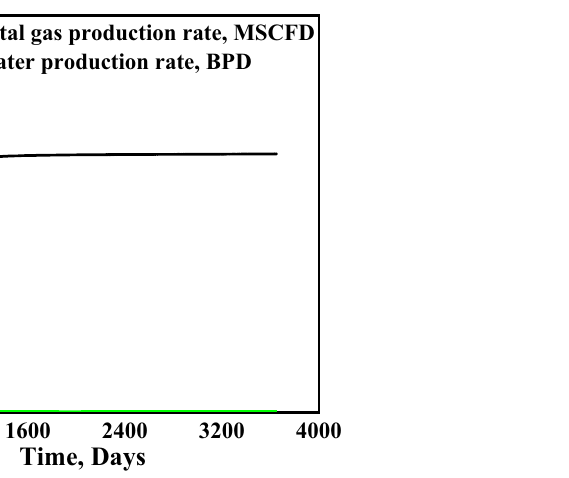
Figure 11. The gas and water production